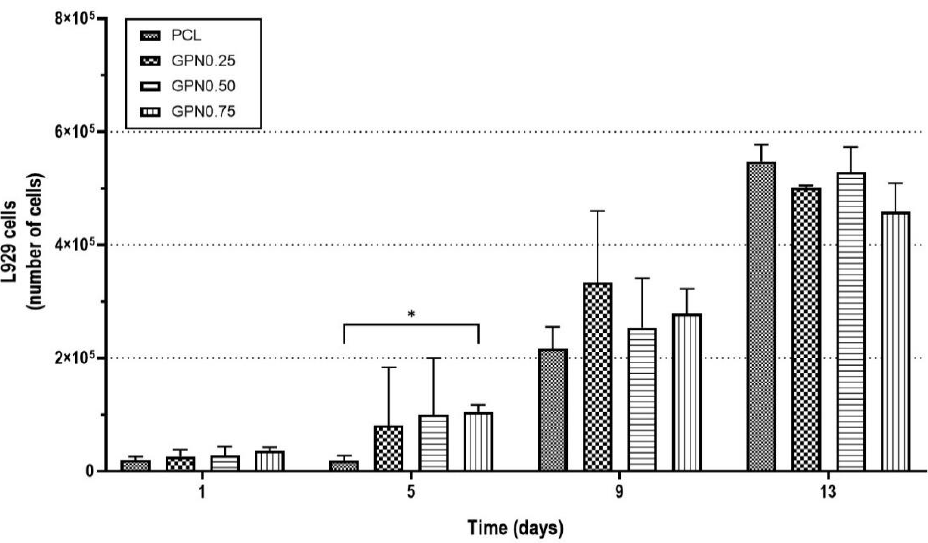
Figure 6. Biological in vitro testing of scaffolds with L929 fibroblasts: cell proliferation assessment. Two-way ANOVA, uncorrected Fisher’s LSD ( n = 3), multiple comparisons. Statistical differences: * p < 0.05.